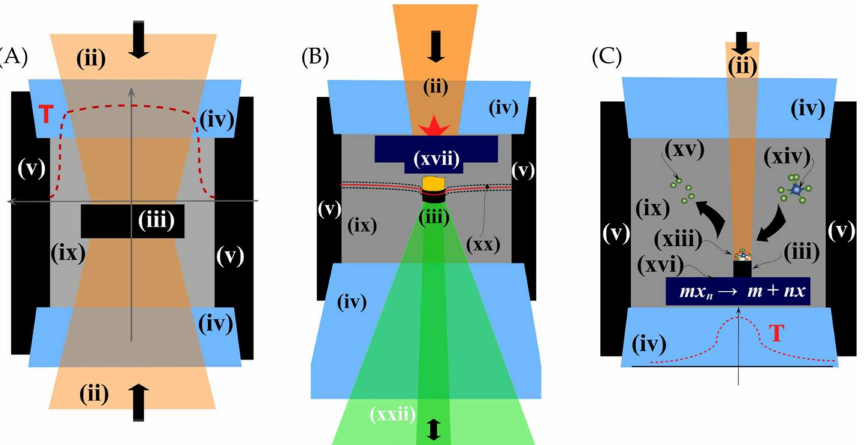
Figure 3. Illustrations of various modes of laser materials processing in L-DAC studies. ( A ) Laser- Heated Diamond Anvil Cell (LH-DAC), ( B ) Laser-driven Dynamic-Compression Diamond Anvil Cell (LDC-DAC), and ( C ) Laser Reactive Synthesis Diamond Anvil Cell (LRS-DACs) experiments. Please see article text for component